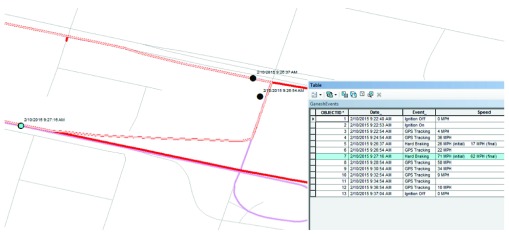
Incorrect routes.